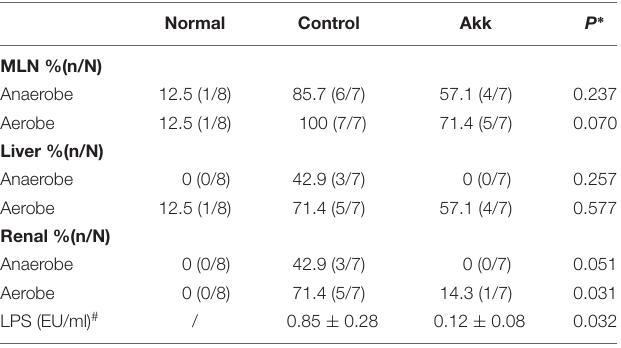
∗ Comparison between group Control and Akk by Chi-square test for categorical data and Mann–Whitney test for LPS; # LPS in group Normal was under the detectable line (0.007